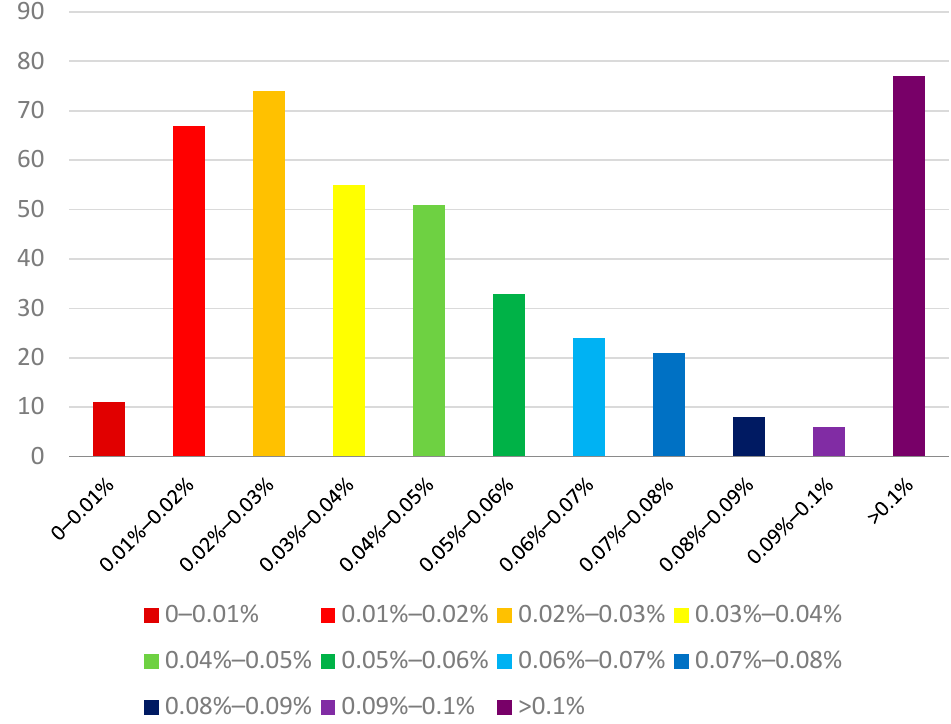
Figure 8. Breakdown by percentage of targets.